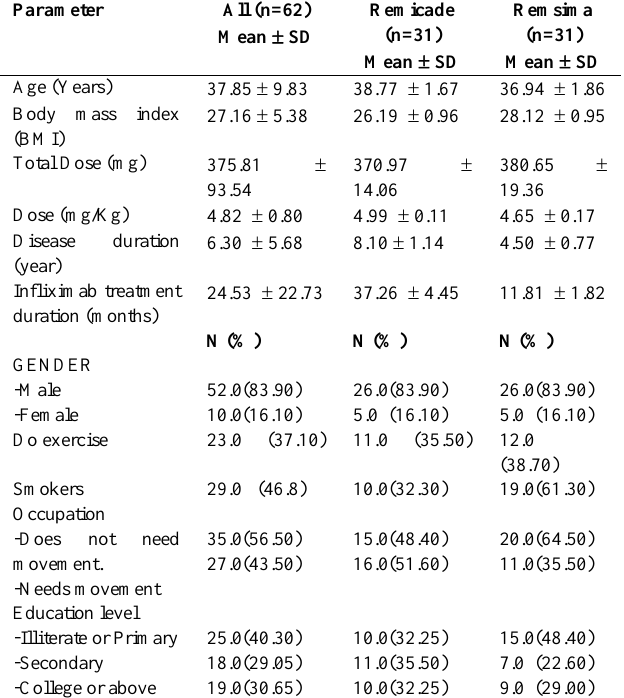
Table 1: The characteristics of the participating AS patients Parameter